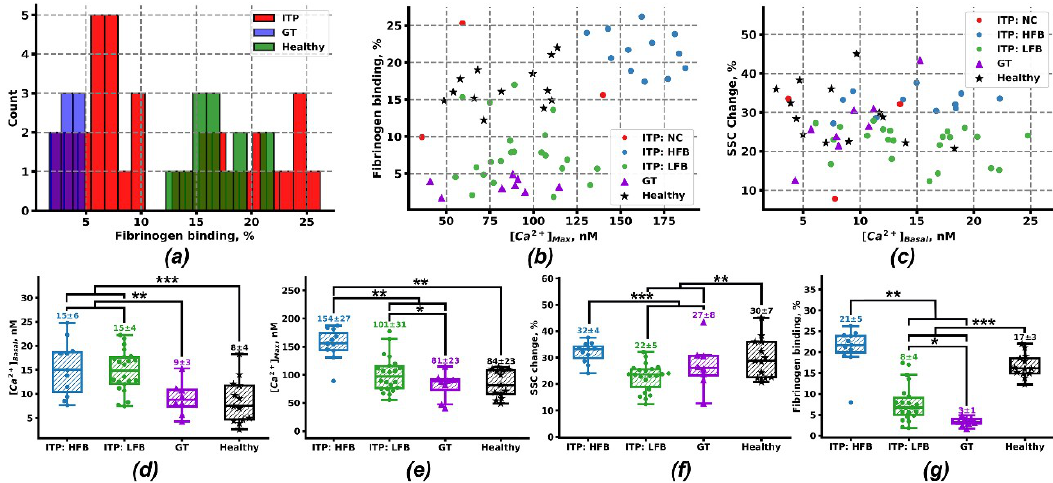
Figure 2. Identification and characterization of subgroups of ITP patients. ( a ) Histogram of fibrinogen binding to platelets of patients with ITP (ITP, red), Glanzmann thrombasthenia (GT, blue) and healthy donors (green). ( b , c ) Cluster analysis of ITP patients by H-DBSCAN (Hierarchical Density-based spatial clustering of applications with noise) clustering algorithm with calcium concentration in quiescent state ([Ca 2 + ] Basal ), maximal calcium concentration ([Ca 2 + ] Max ), relative fibrinogen binding and relative SSC-A change upon activation with 2 µ M of ADP as coordinates revealed two subgroups, high fibrinogen binding (ITP: high fibrinogen binding (HFB), n = 12, blue circles) and low fibrinogen binding (ITP: low fibrinogen binding (LFB), n = 21, green circles). Three patients did not adhere to any of the groups (ITP: NC, red circles). The same characteristics for GT (purple triangles) and healthy donors (black stars) are given for comparison purposes. ( d − g ) Mean values ± SEM for the analyzed groups upon platelet stimulation with ADP for maximal calcium concentration ( d ), basal calcium concentration ( e ), shape change ( f ), and fibrinogen binding ( g ). Statistics was calculated by Mann-Whitney test, * p < 0.05, ** p < 0.01, *** p < 0.001.